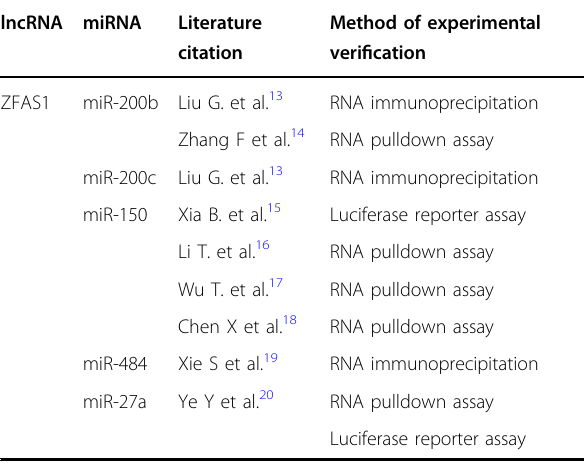
Table 2 List of lncRNA-miRNA